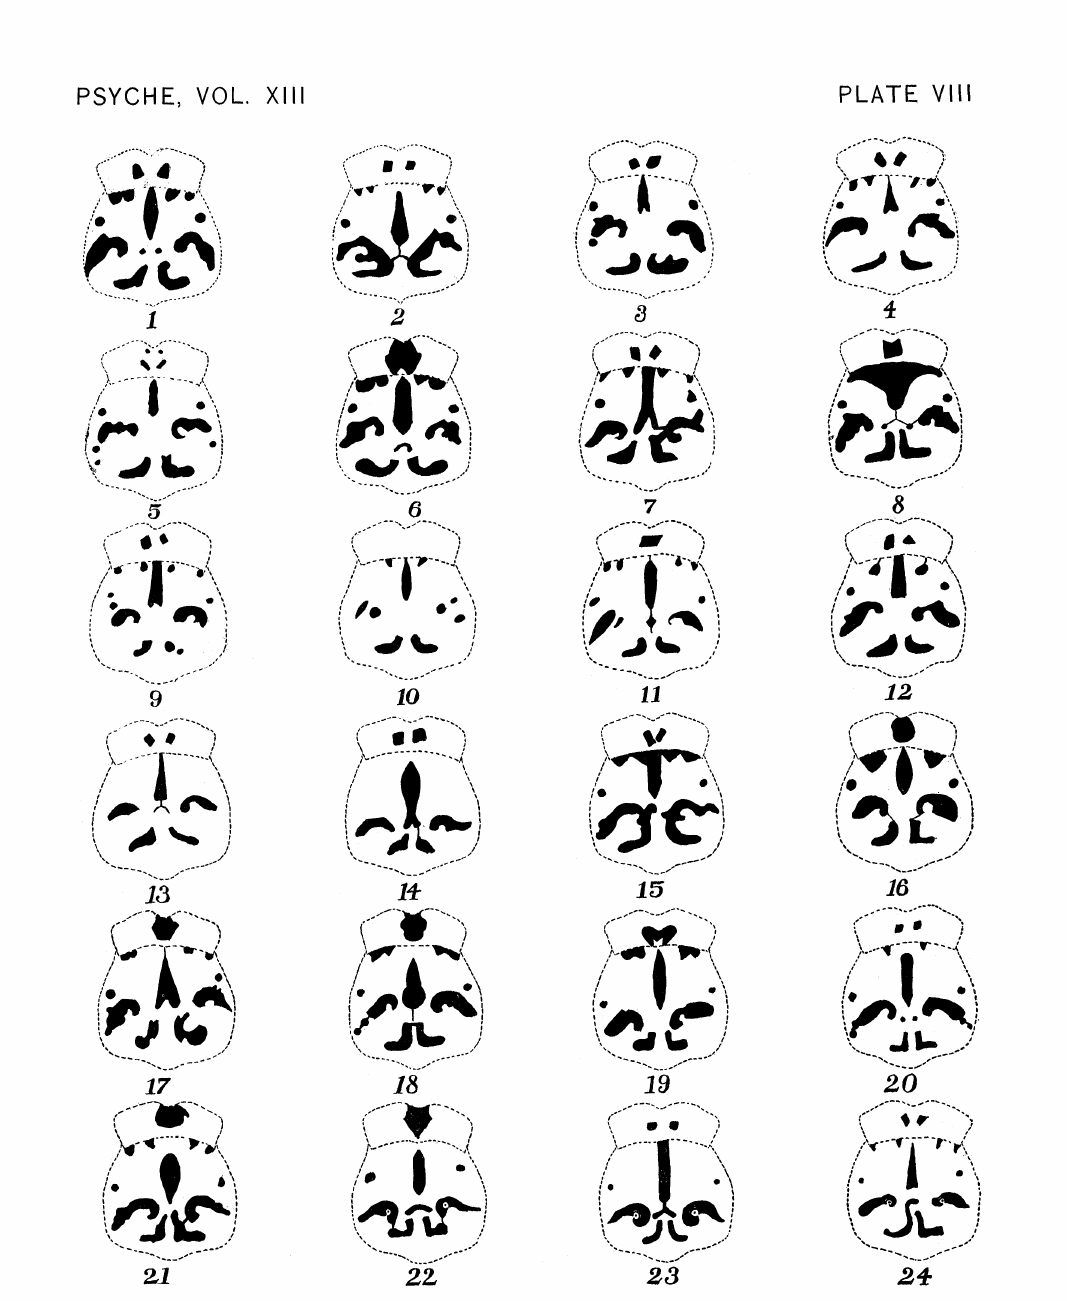
Diagrammatic representation of variations in the color-pattern of the antero-ventral aspect of the naked chrysalid of the checker-spot butterfly, Melitaea